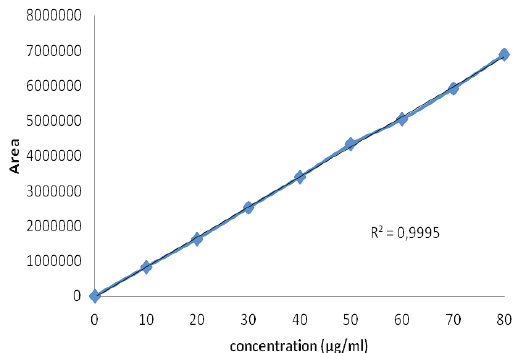
Figure 6. Linearity curve of Finasteride Linearity: The linearity range for TAM and FIN were 4-40 μg/mL and 10-80 μg/mL, respectively (Figure 5 and 6). The correlation coefficient values were found to be greater